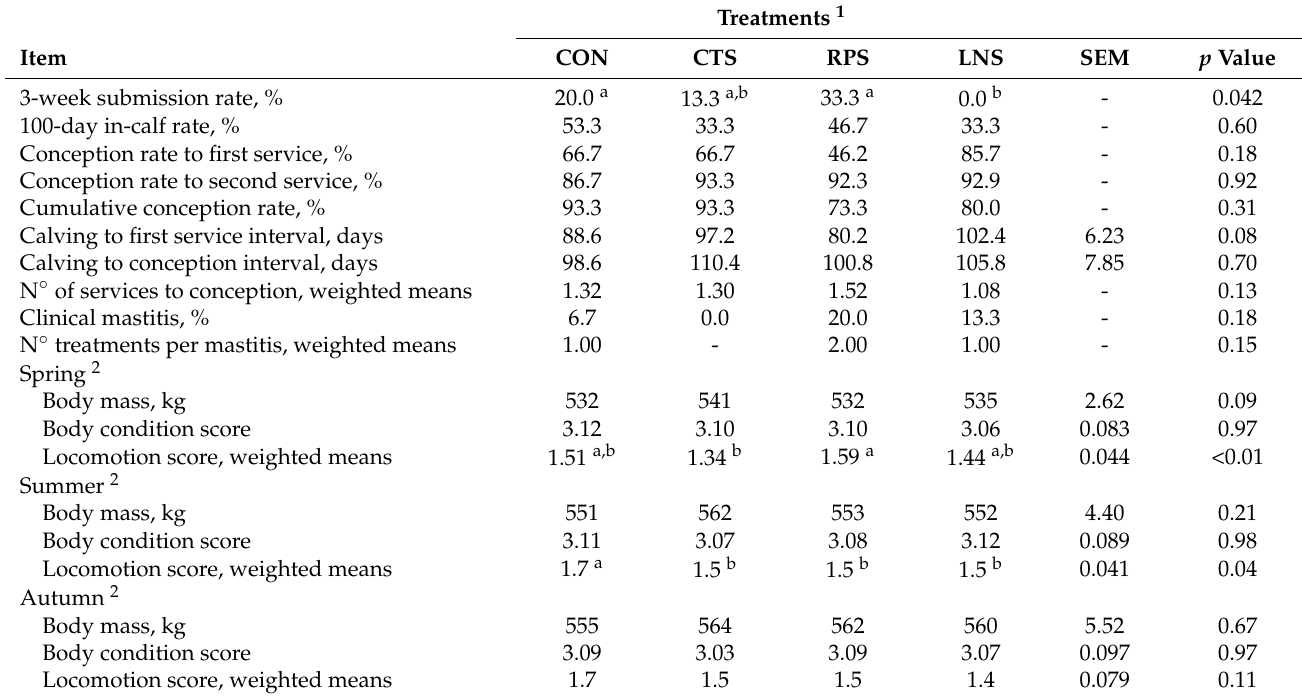
Table 6. Effect of oilseed supplementation on reproductive and health performance of grazing dairy cows. Treatments